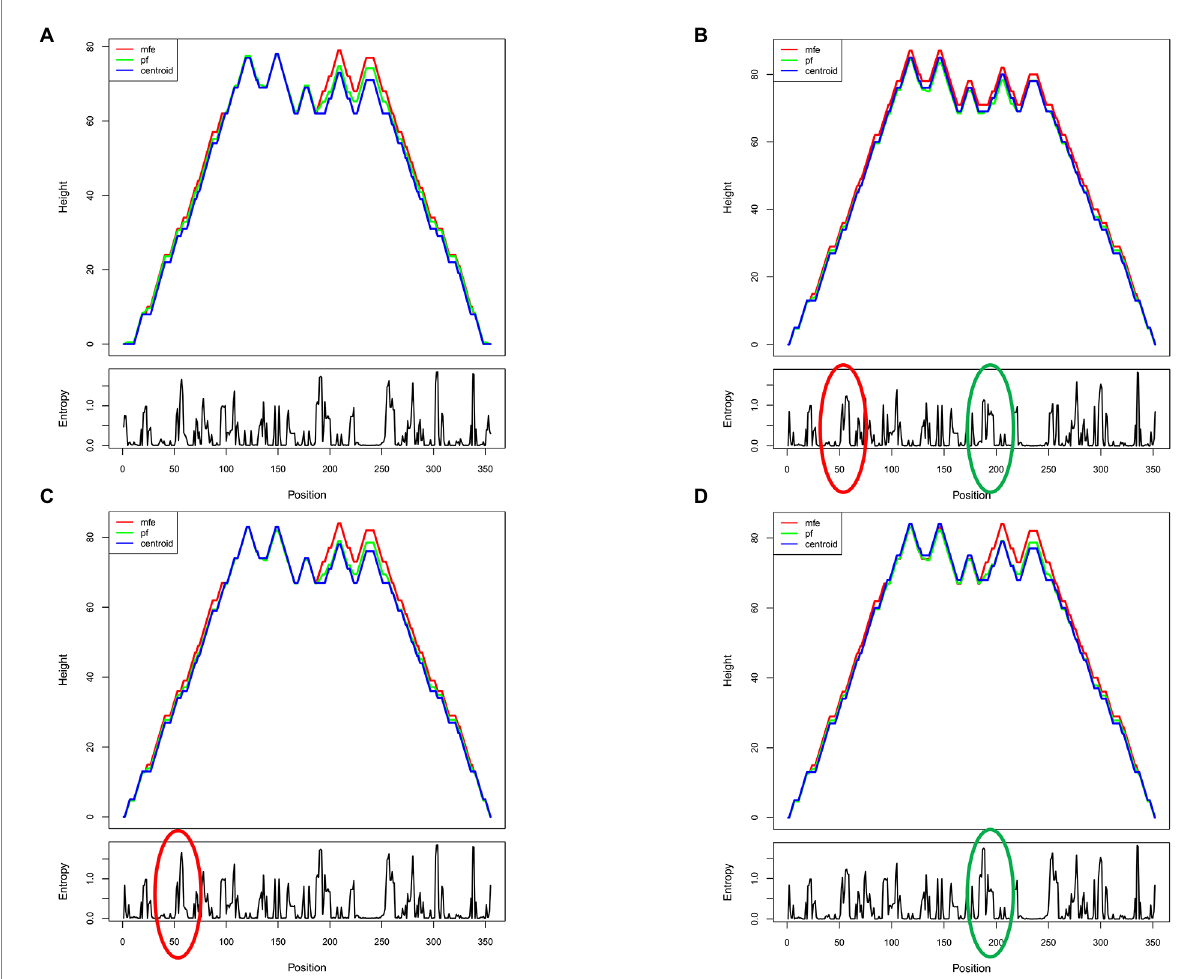
FIGURE 4 Predicted shannon entropy profile of subtype B RRE and each mutation site. (A) The Shannon entropy spectrum of subtype B in China. (B) The Shannon entropy spectrum of subtype B in the United States. (C,D) Mutation at site RRE56-57insAAC and site RRE-G186A,